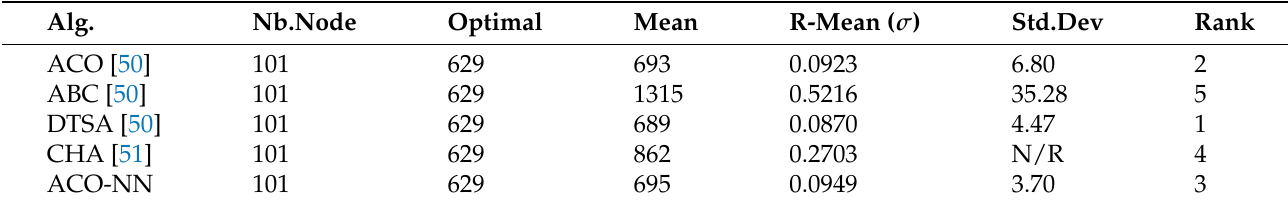
Table 6. Comparison of ACO-NN to various approaches for